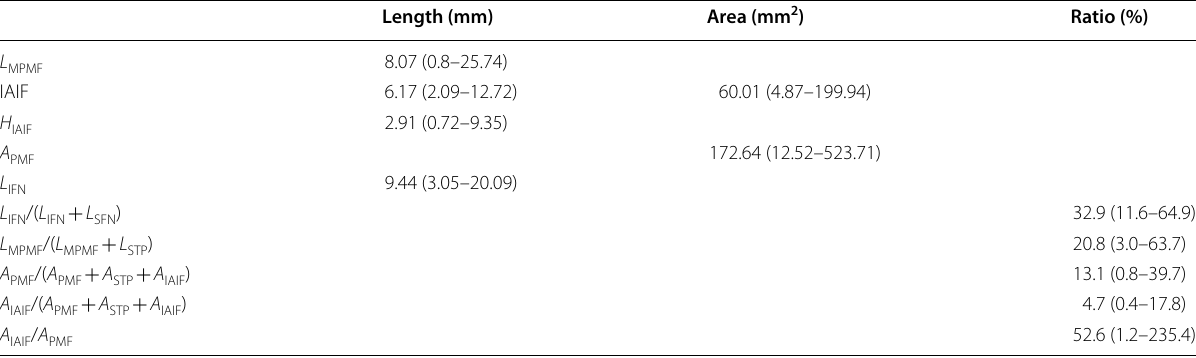
Values are given as the mean, with the range in parentheses